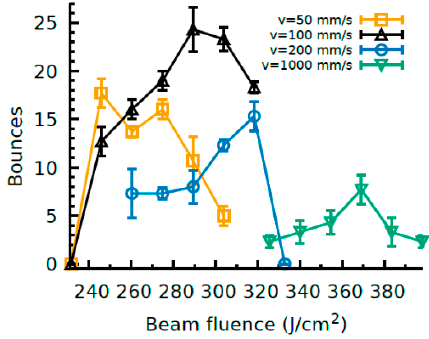
Figure 4. Drop bounces for the coatings ablated with different values of beam velocity and fluence.